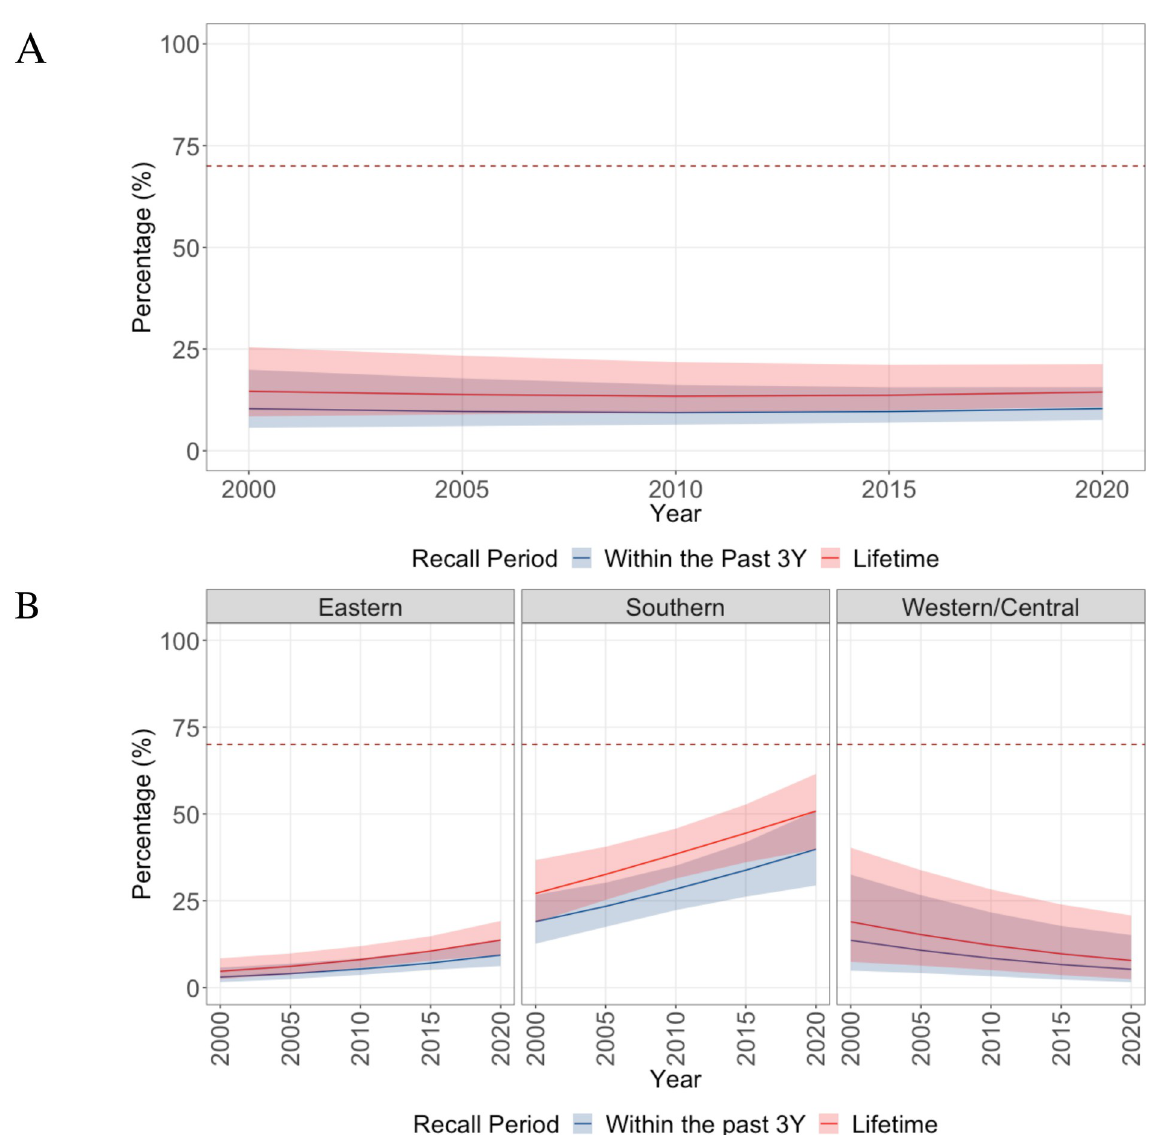
Fig 3. Overall and regional-level trends in lifetime and past 3 years CC screening coverage among women aged 30–49 years between 2000–2020 in sub-Saharan Africa. AU : AbbreviationlistshavebeencompiledforthoseusedinFigs 3 ; 5 ; 6 andTable 1 : Pleaseverifythatallentriesarecorrect : (A) Overall time trends for proportion of women screened. (B) Time trends for proportion of women screened by region. The red trendline represents the median lifetime screening trends. The blue trendline represents the median screening trends for screening in the past 3 years. The dotted red line represents the 70% screening goal set by the WHO. Shaded regions represent the 95% CrIs. CC, cervical cancer; CrI, credible interval; WHO, World Health